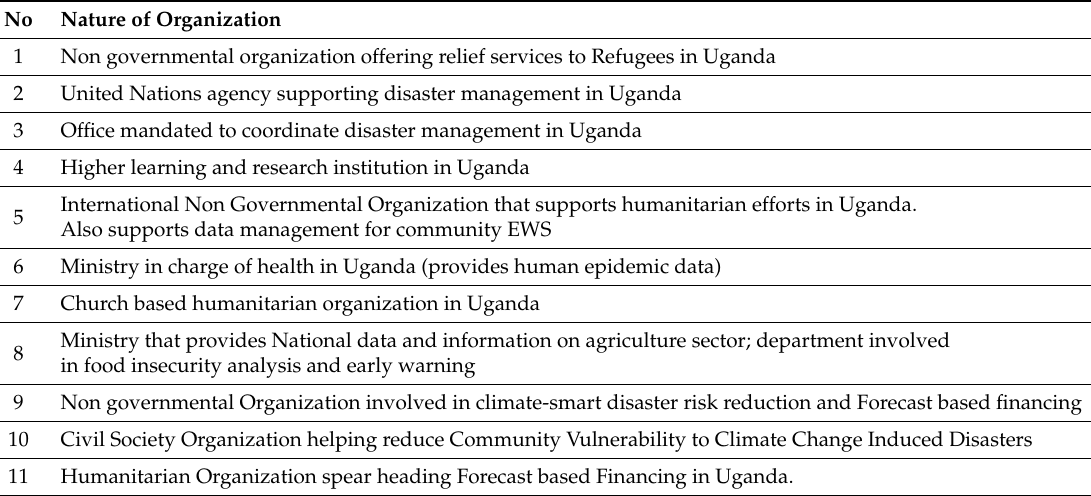
Table A4. Nature of organization where focused group discussions (FGD) participants were